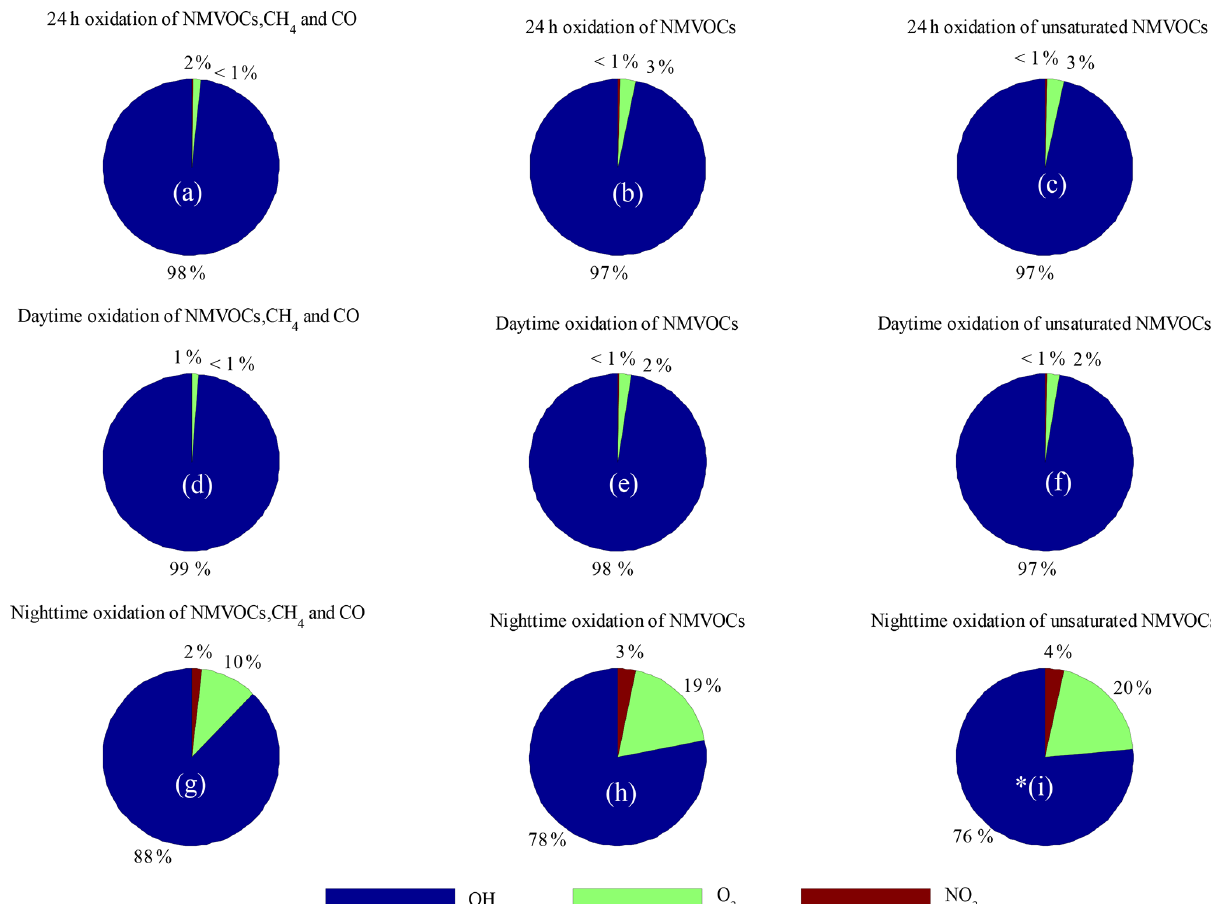
Figure 8. Comparison of the relative contributions of OH, NO 3 and O 3 to the 24h, daytime and nighttime-averaged loss rates. Data are calculated for the loss rates of (a, d, g) NMVOCs, CH 4 and CO; (b, e, h) NMVOCs only; and (c, f, i) unsaturated NMVOCs